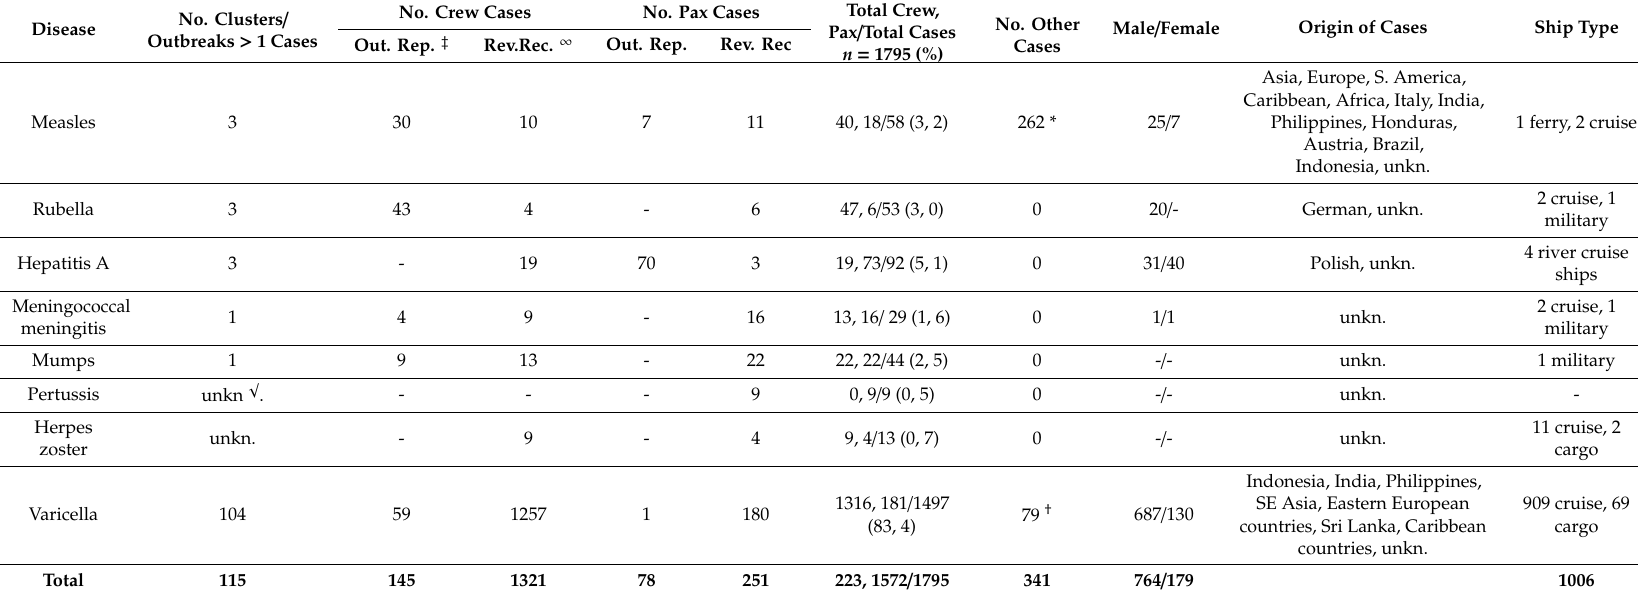
Table 4. Characteristics of cases from reported outbreaks, case reports, and record reviews (results from seroprevalence studies not included).